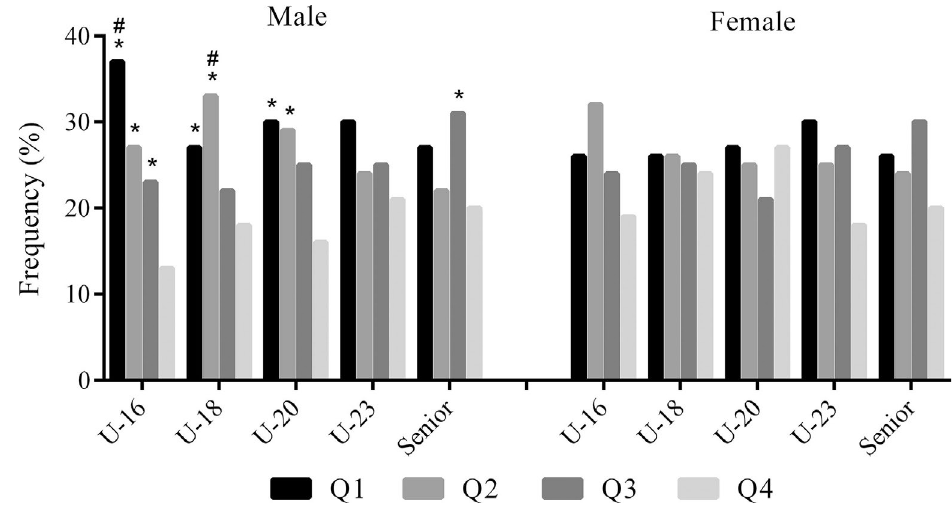
Figure 2 - Brazilian track and field athletes’ quarters of birth organized by sex and age category. # means different from Q3; * means different from Q4.